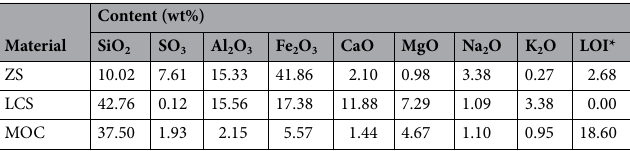
Table 2. Chemical composition of test materials. *Loss on